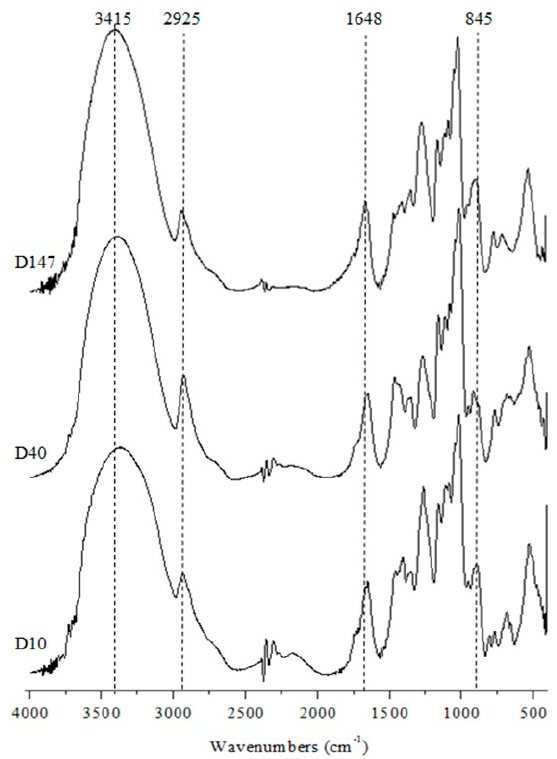
Figure 1. Fourier transform infrared spectroscopy (FTIR) spectra of the dextrans. The characteristics signals are in evidence for the regions between 4000 and 400 cm − 1 .